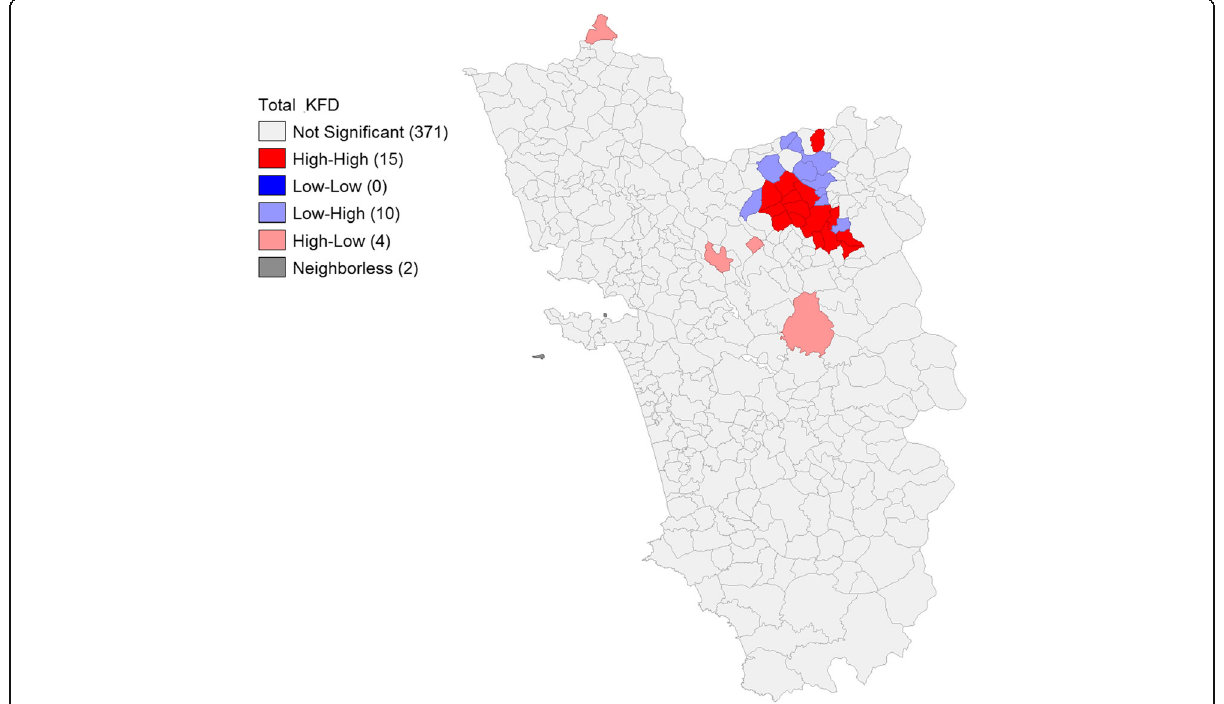
Fig. 10 Hot spots and cold spots of cases of Kyasanur Forest Disease in Goa, 2015 –